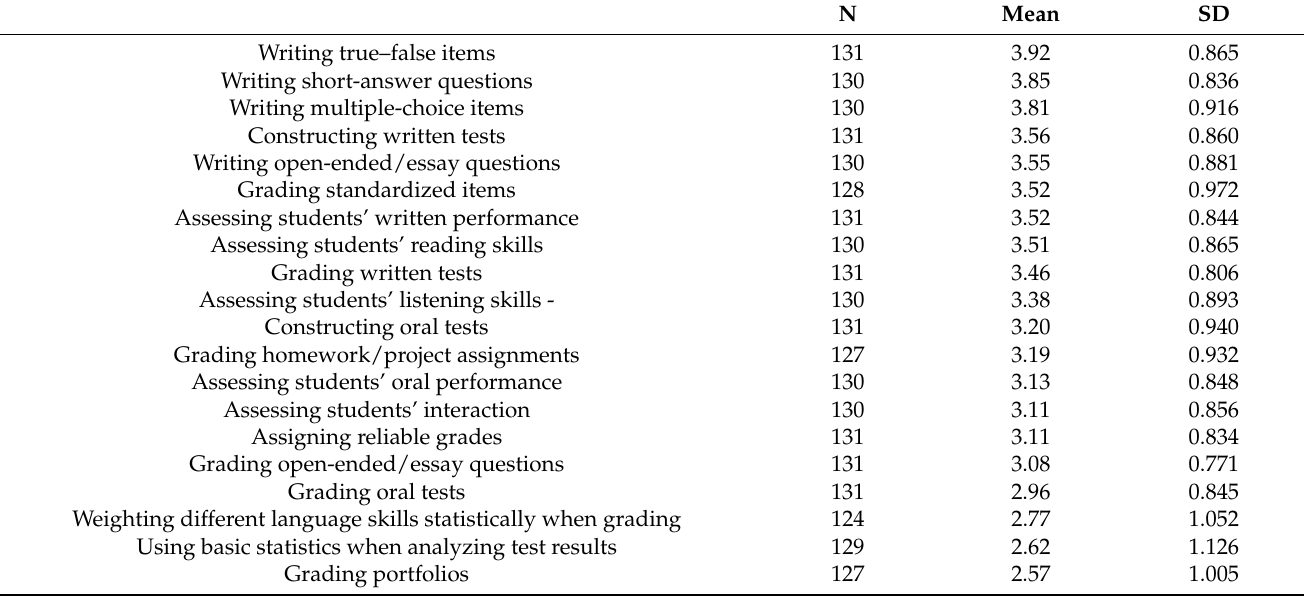
Table 6. Pre-service teachers’ perceived competence in summative assessment